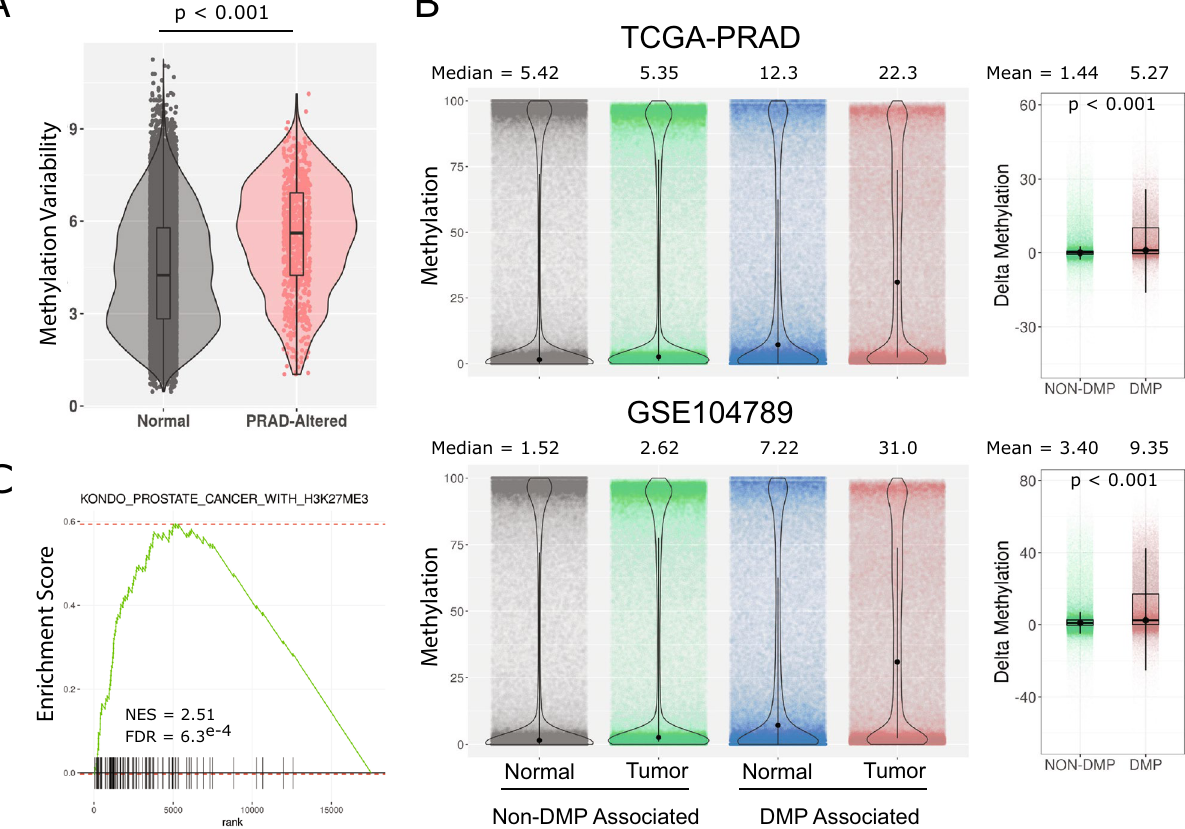
Figure 4. Regions of dynamic methylation associate with cancer susceptibility loci. ( A ) Overall androgen induced methylation variation over time was assessed for all TSS of genes expressed in HPr1-AR cells. The methylation variance of a set of genes previously reported to be associated with altered methylation in prostate cancer 15 was examined and compared to background genes. Differences in distributions were determined by Wilcox test. ( B ) CpG island regions (UCSC) were compiled and parsed into DMP or Non-DMP associated regions. The overall methylation distributions of each group of regions was examined across normal and tumor samples from both the TCGA-PRAD and GSE104789 cohorts. ( C ) Select enrichment plot showing high association of methylation variable genes in HPr1-AR cells with genes associated with altered H3K27me3 in